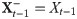
Schematic illustration of AIS estimation and relationship with other information-theoretic measures.(A) Schematic illustration of relationship between AIS (blue box), conditional entropy of the next fixation given the past state (orange box) and the joint entropy between past state and next fixation (grey box). For Xt-1-=Xt-1, the conditional entropy is equivalent to the GTE. (Adapted from [38]). (B) Schematic illustration of the non-uniform embedding (modified from [14]). The blue box indicates all past variables up to a maximum lag, lmax, that are considered during the optimization of the past state for AIS estimation. The red marker indicates the next fixation, Xt, and blue markers indicate the variables selected by the optimization that comprise the optimized past state, Xt-1-.